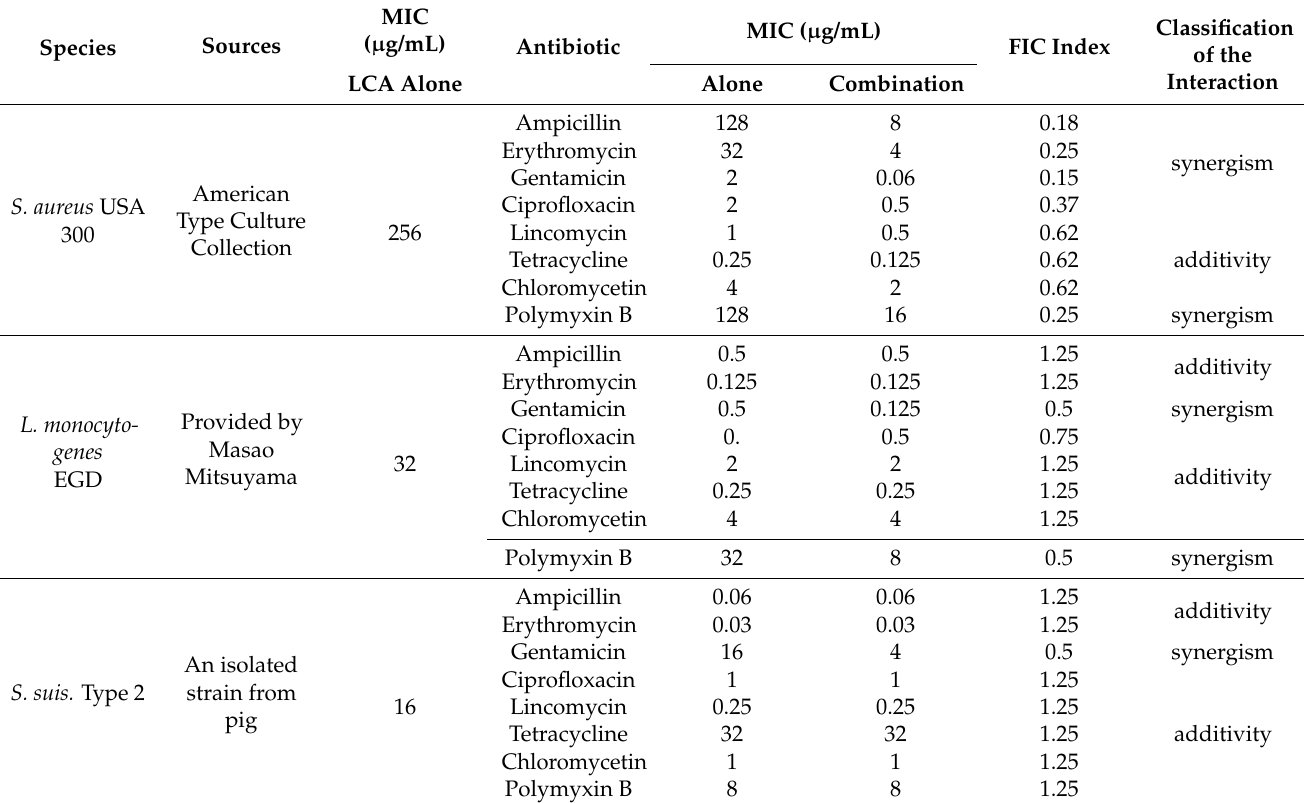
Figure 2. Interaction of LCA with Amp, Ery, Genta, Cip, Lin, Tet, Cpl and Pmb against L. monocyto- genes ( A – H ). Table 1. The MIC and FIC index determination of LCA combined with different antibiotics against Gram-positive bacteria.